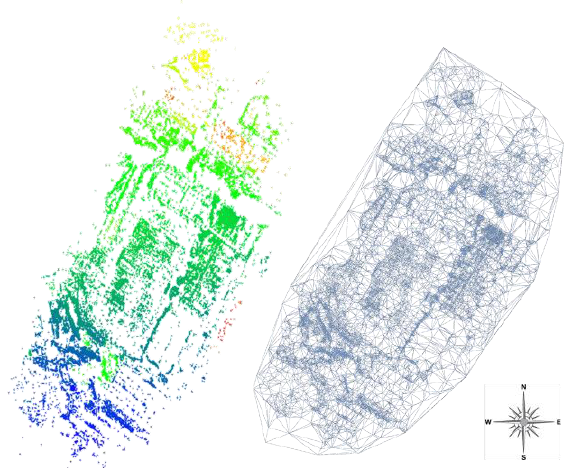
Figure 7. Example of a TIN generated